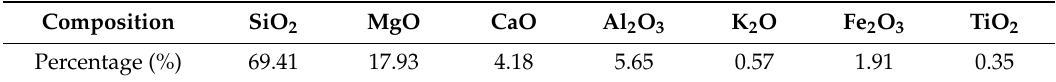
Table 1. Chemical Composition of the